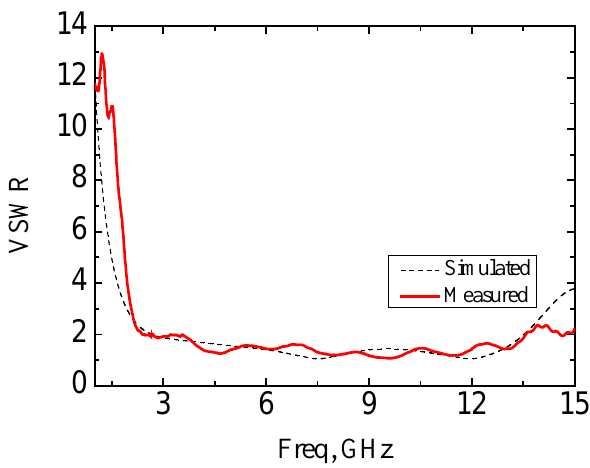
Figure 13. Simulation and experimental measurement of the reflection coefficient of the proposed antenna.